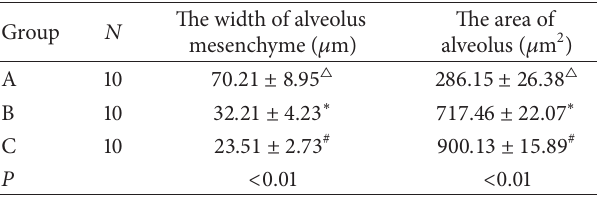
Table 5: Comparison of morphological development of fetal rat lungs in three groups (𝑥 ± s